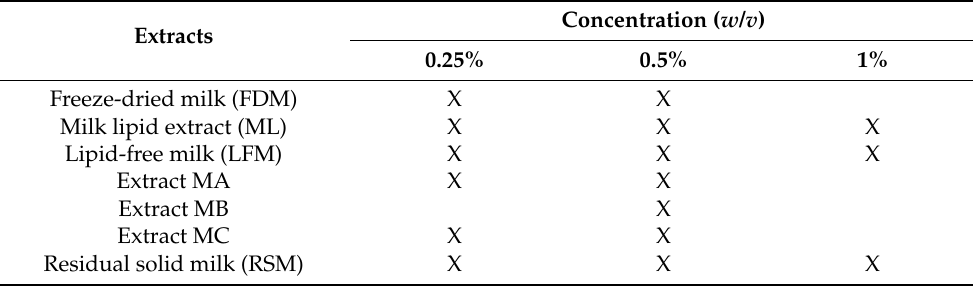
Table 1. Concentrations of the dried milk extracts used for supplementing the medium. Concentra- tions are expressed in percentage of extracts relative to the volume of medium.